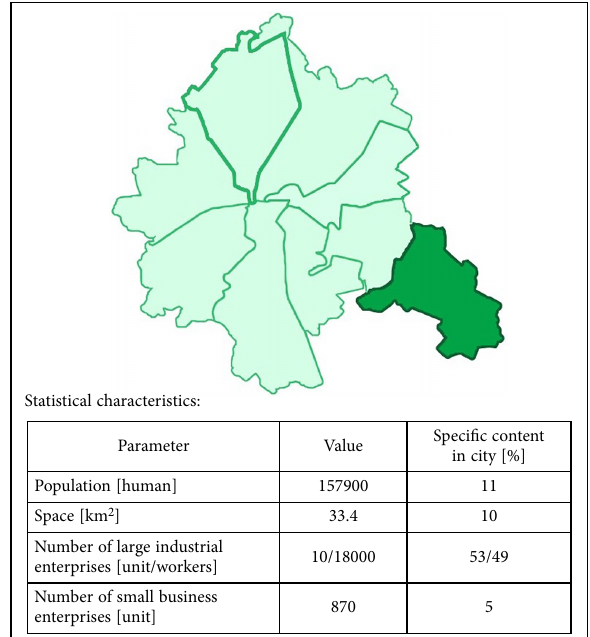
Figure 2. Scheme and statistical characteristics of the Industrial District of Kharkiv City Table 1. The spatial and quantitative characteristics of the public transport network in the Industrial